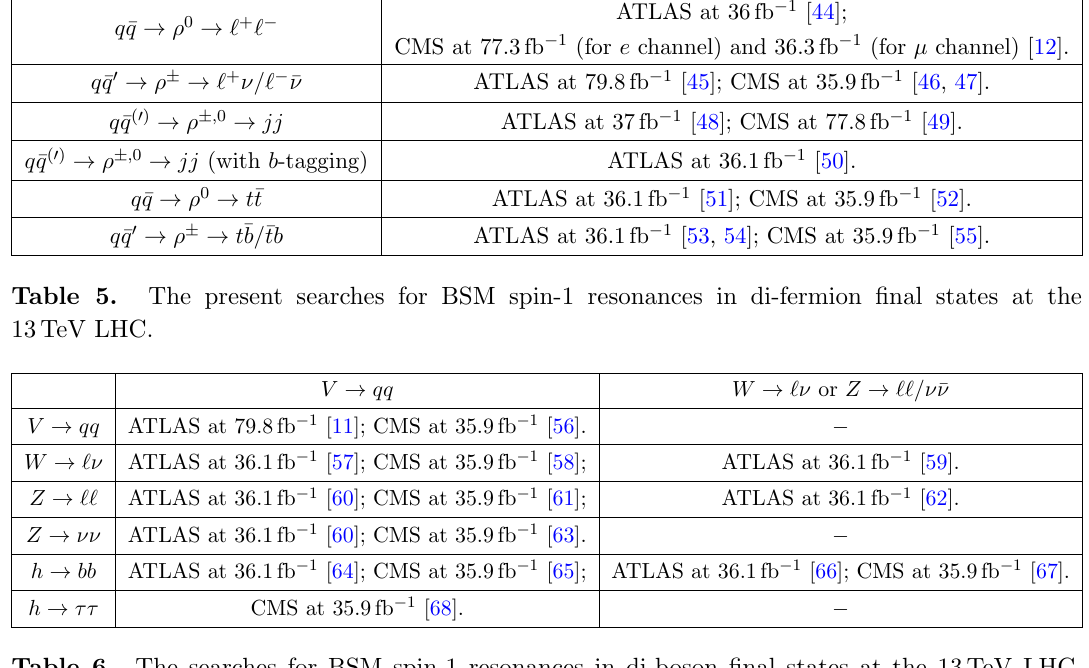
Table 6. The searches for BSM spin-1 resonances in di-boson (cid:12)nal states at the 13 TeV LHC, where V denotes W (cid:6) , Z . The search in ref. [62] is also sensitive to the VBF production of (cid:26) (cid:6) , but the constraint is quite weak ( . 1 TeV). For a summary of the di-boson results from ATLAS at (cid:24) 36 fb (cid:0) 1 , we refer the readers to ref.